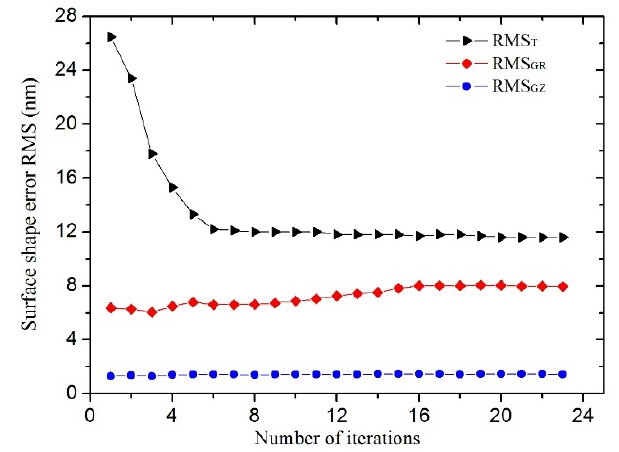
Figure 7. Iterative history of the mirror surface shape error. Table 4. Comparison of initial and optimal primary mirror component design.